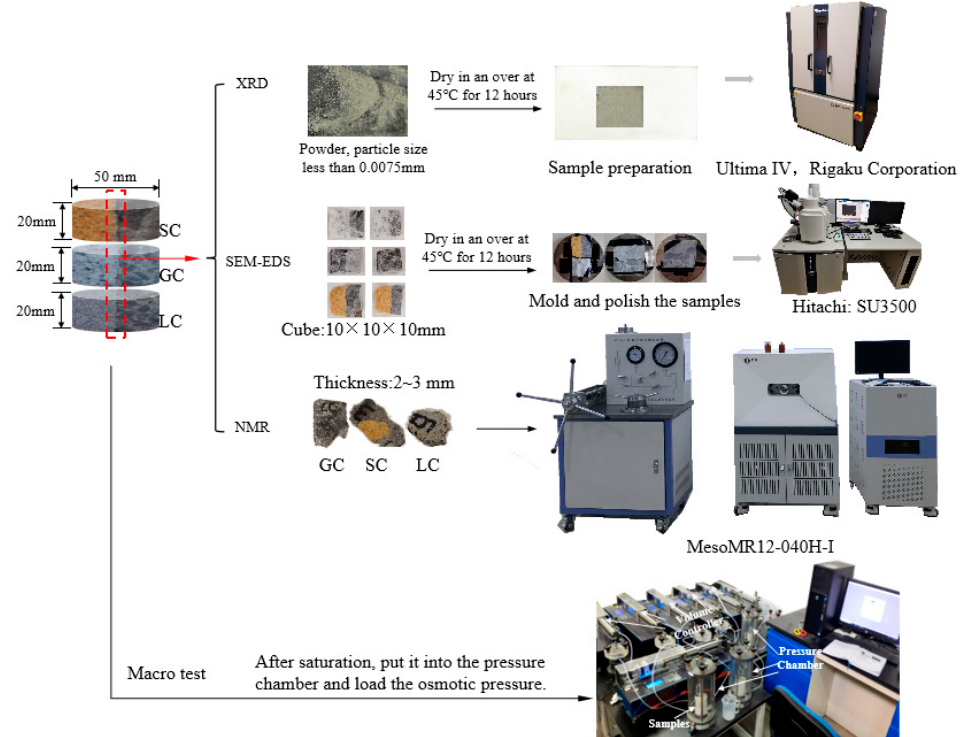
Figure 2. Macro and micro test schemes.